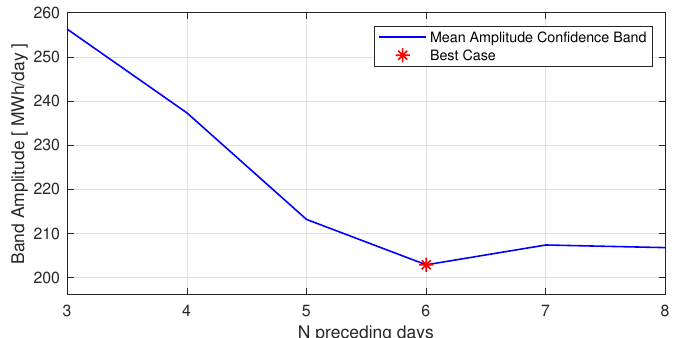
Figure 5. Sensitivity analysis to select the number of days for the moving average computation.